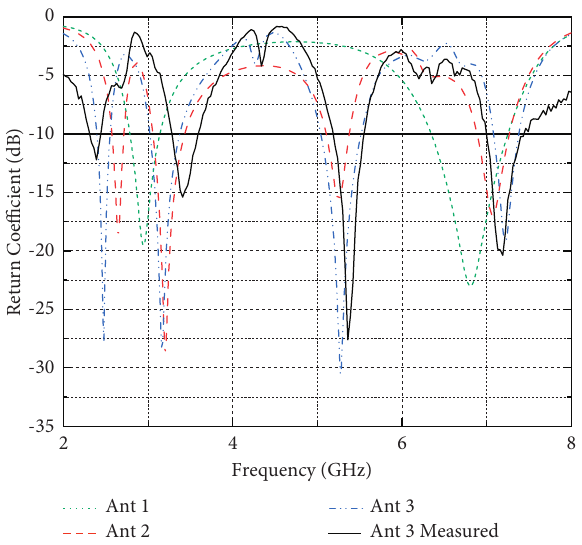
Figure 6: Simulated and measured S parameters. Table 3: Working frequency ranges of different